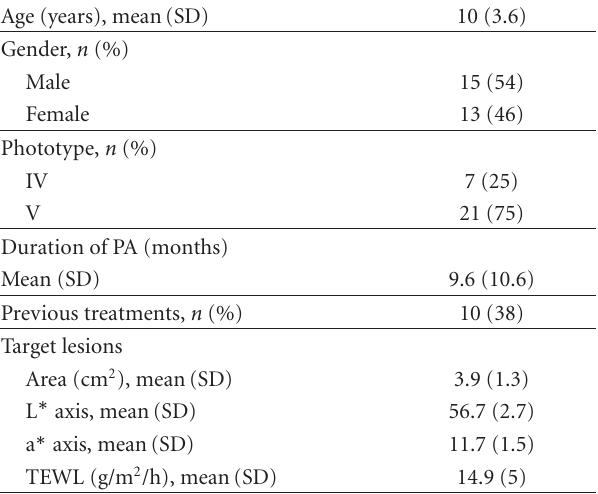
Table 1: Demographics, and clinical features of the 28 patients at